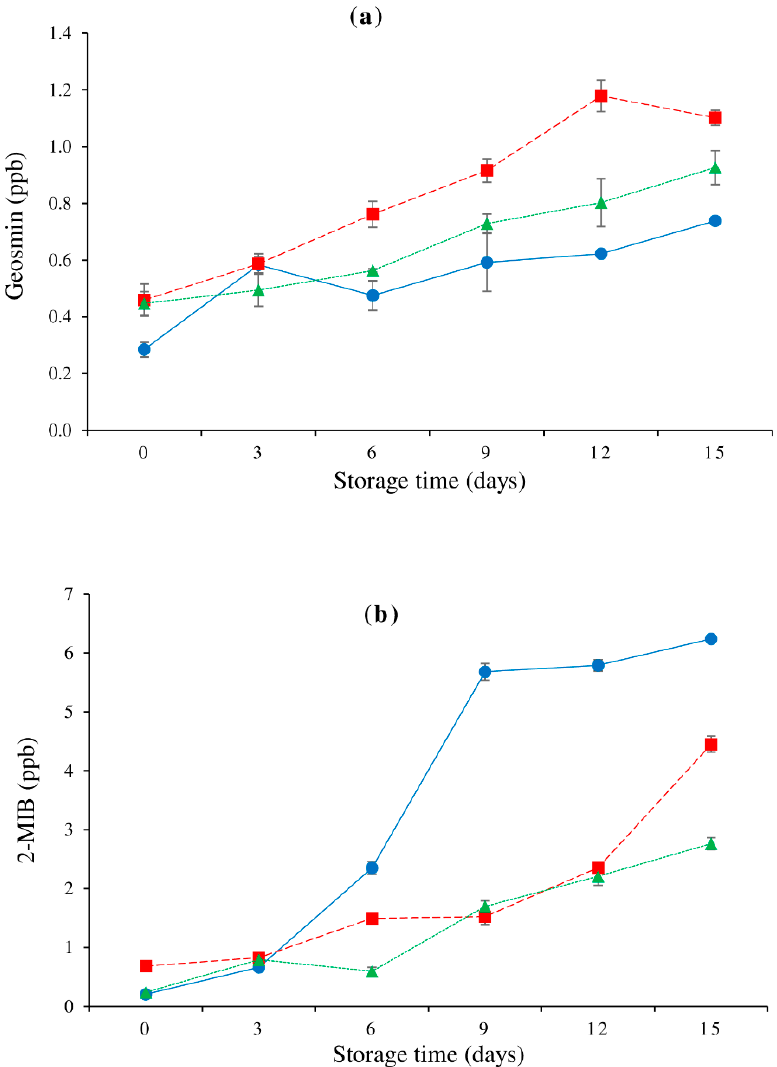
Figure 3. Changes in geosmin ( a ) and 2-MIB ( b ) of farmed hybrid catfish dorsal muscle ( ⎯ ● ⎯ ), lateral line (--- ■ ---), and ventral muscle ( … ▲ … ) during 15 days of refrigerated storage. The bars indicate standard deviation from triplicate determinations.